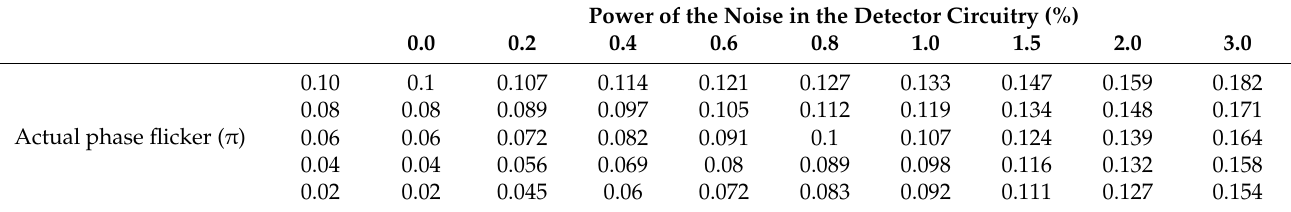
Table 1. The calculated worst-case phase flicker under different simulation conditions (unit: π ). Power of the Noise in the Detector Circuitry (%)